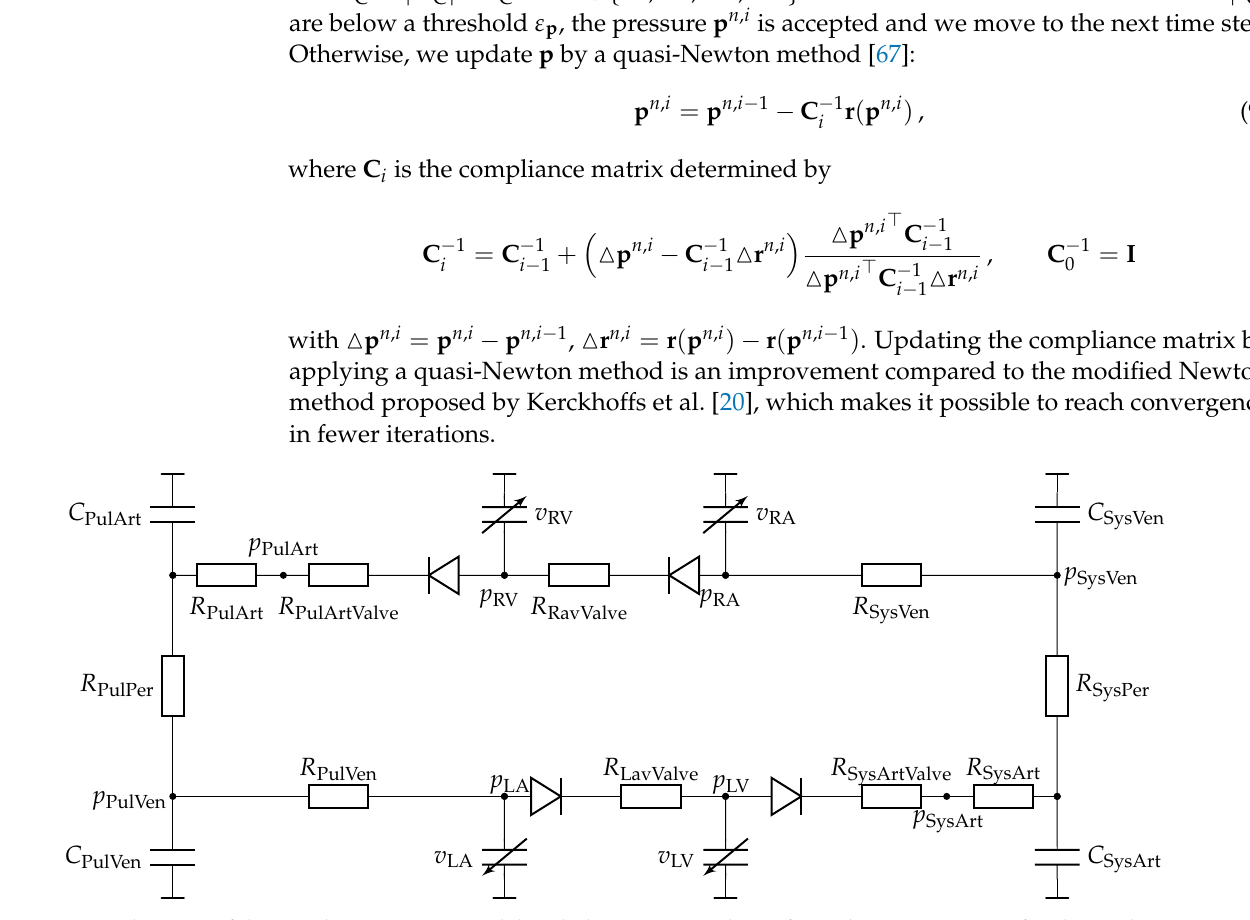
Figure 2. Schematic of the circulatory system model with the pressure values of p and z , resistances R , fixed compliances C and volumes of variable compliances v C with C ∈ { LV, RV, LA, RA }